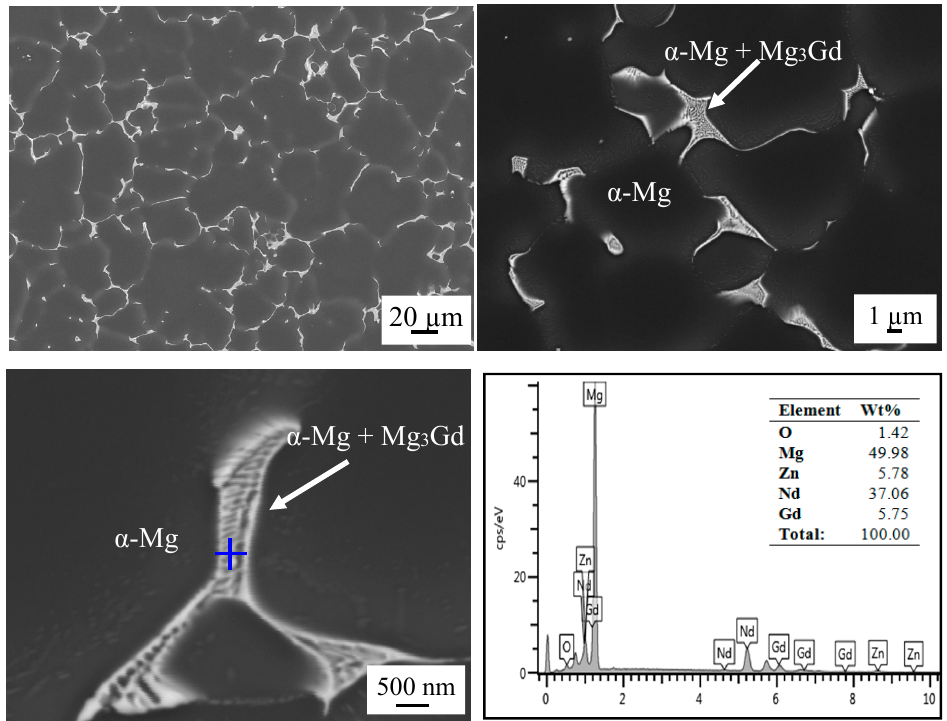
Figure 2. Microstructure and corresponding EDS analysis of El21 as-cast alloy.